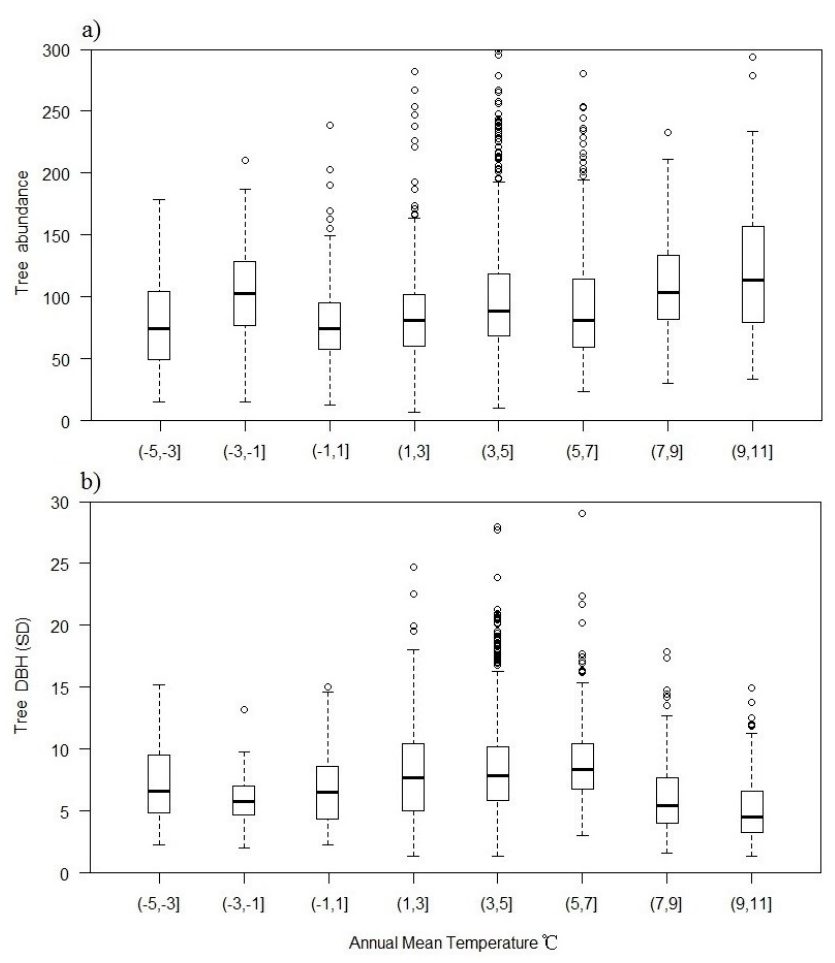
Figure 6. Relationships between the tree structure and annual mean temperature: ( a ) tree abundance and ( b ) tree DBH (SD).